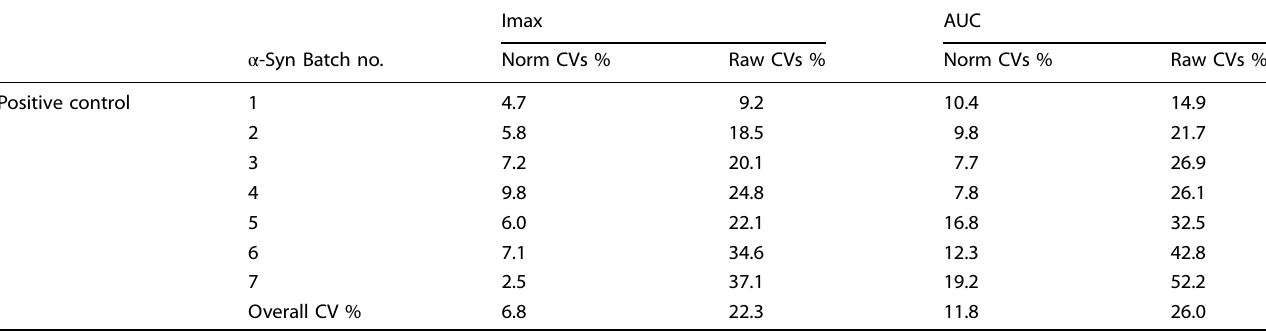
Table 3. Intra-batch and inter-batch coef fi cients of variation (%) of quantitative RT-QuIC parameters of the positive control, before (raw) and after